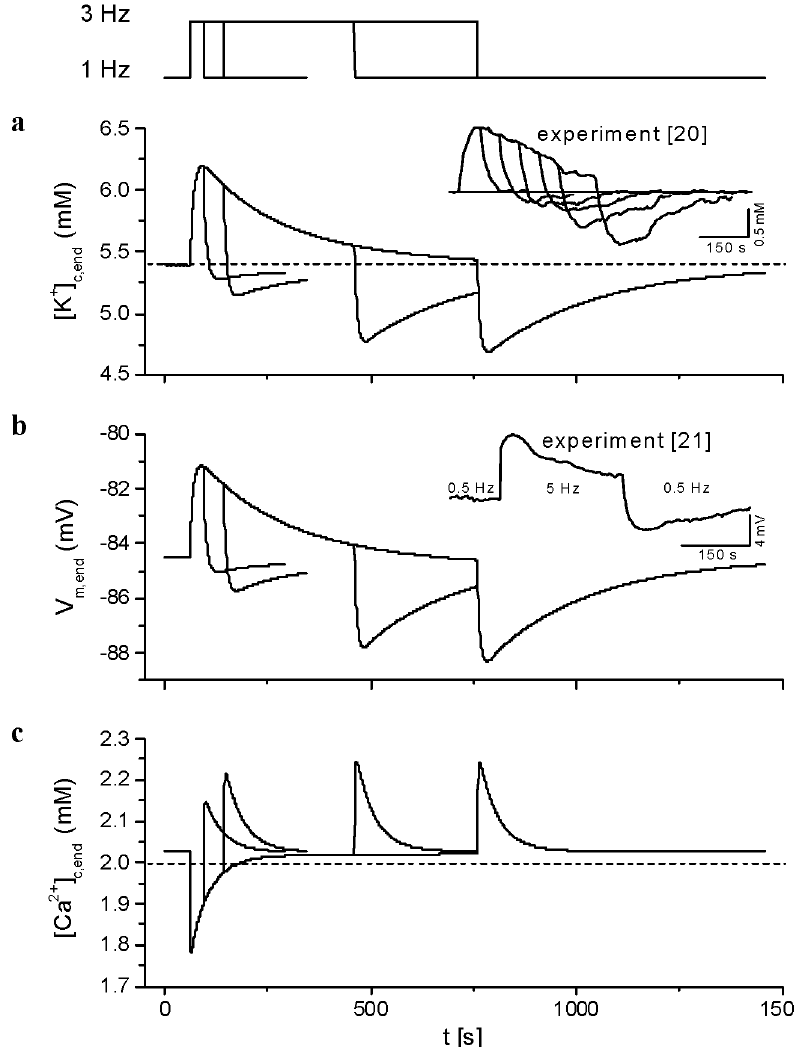
Figure 7. Accumulation-depletion phenomena during and after a high frequency train of stimulations. From a period of stimulation at 1 Hz, a train of stimuli at 3 Hz has been applied for four different durations: 34, 144, 400 and 700 s. From up to down are plotted superimposed outputs of the model for the four durations: the timing of changes in the frequency of stimulation, the time course of changes in the end-diastolic values of cleft K + concentration ( a ), membrane voltage ( b ) and cleft Ca 2+ concentration ( c ). The horizontal dashed lines show the levels of corresponding ion concentrations in external bulk solution. The insets show the corresponding experimental records digitized from Kunze [20] and Attwell et al.